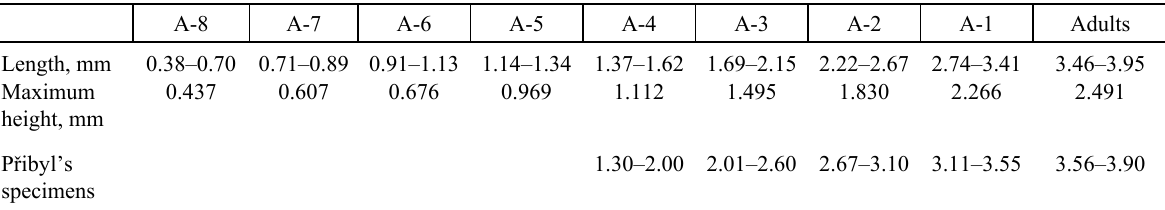
Table 2. Instars of Conchoprimitia osekensis (P ř ibyl, 1979) and their size